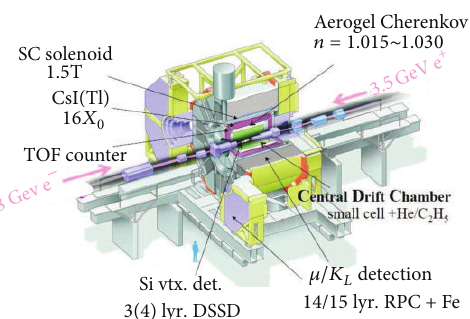
Figure 30: Layout of the Belle